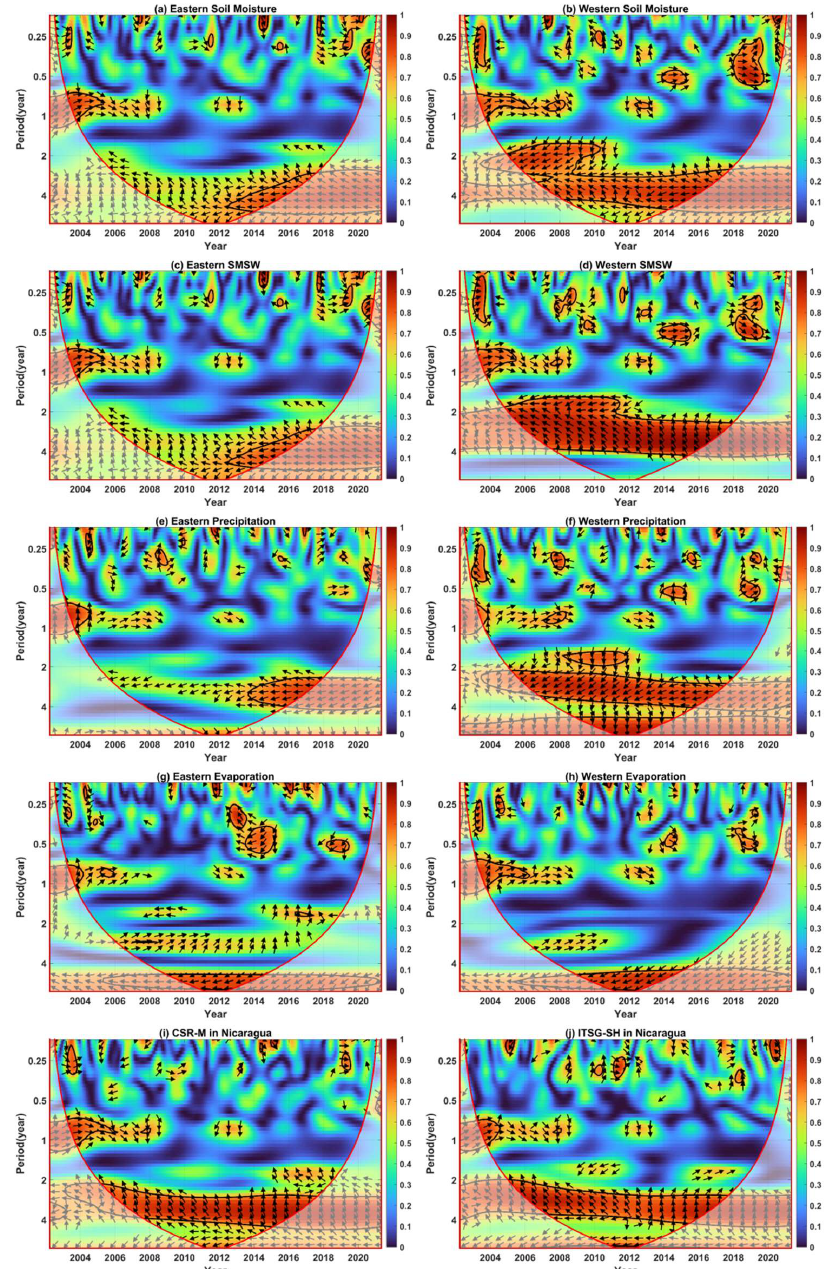
Figure 10. The cross-wavelet transforms between ENSO and eastern soil moisture ( a ), SMSW ( c ), precipitation ( e ), and evaporation ( g ), the cross-wavelet transforms between ENSO and western soil moisture ( b ), SMSW ( d ), precipitation ( f ), and evaporation ( h ), and the cross-wavelet transforms between ENSO and TWS (CSR-M ( i ) and ITSG-SH ( j )) in Nicaragua. The solid red lines are the edge of the influence cone. The 5% significance level against red noise is exhibited as thick lines, and the relative phase relationship is denoted as arrows (with in-phase pointing right, antiphase pointing left, and time series (TWSC changes, precipitation, and evaporation) leading ENSO by 90° pointing straight down).